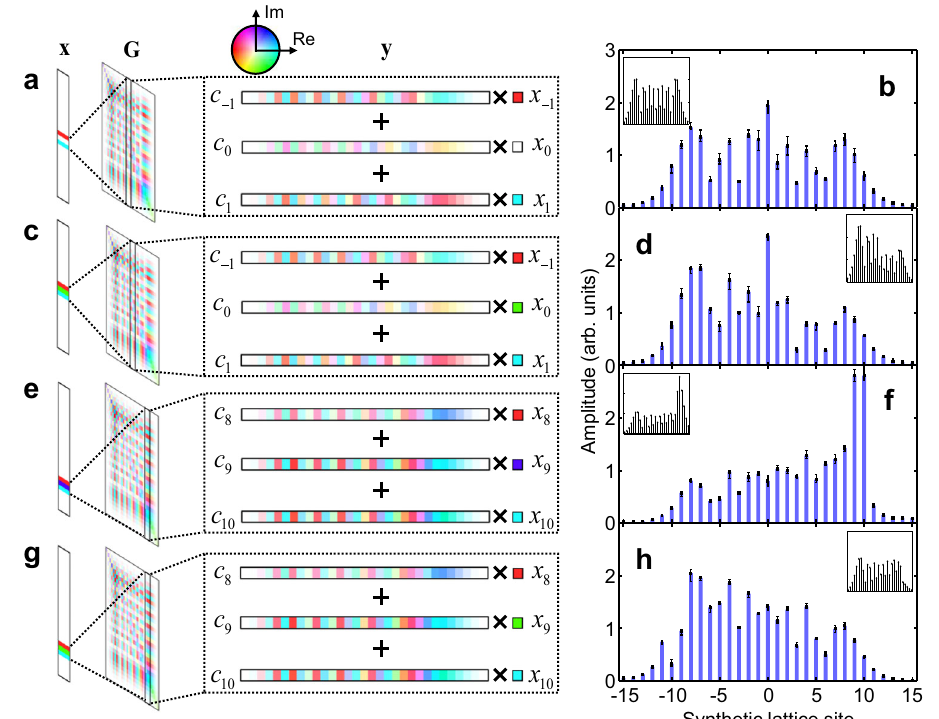
Fig. 3 | Large-scale coherent matrix-vector multiplications in the synthetic frequency dimension. The large matrix G is con fi gured by driving our acousto- optic modulator at 803MHz with − 13dBm power ( β =11.3). The vector input x of three coherent frequency components is synthesized and controlled by an inten- sity modulator M I . a MVM with laser frequency at the 0th synthetic lattice site ( Δ =0) and M I set at suppressed carrier transmission. c Δ =0 and M I set with three equal-amplitude components and a negative phase on the carrier transmission.